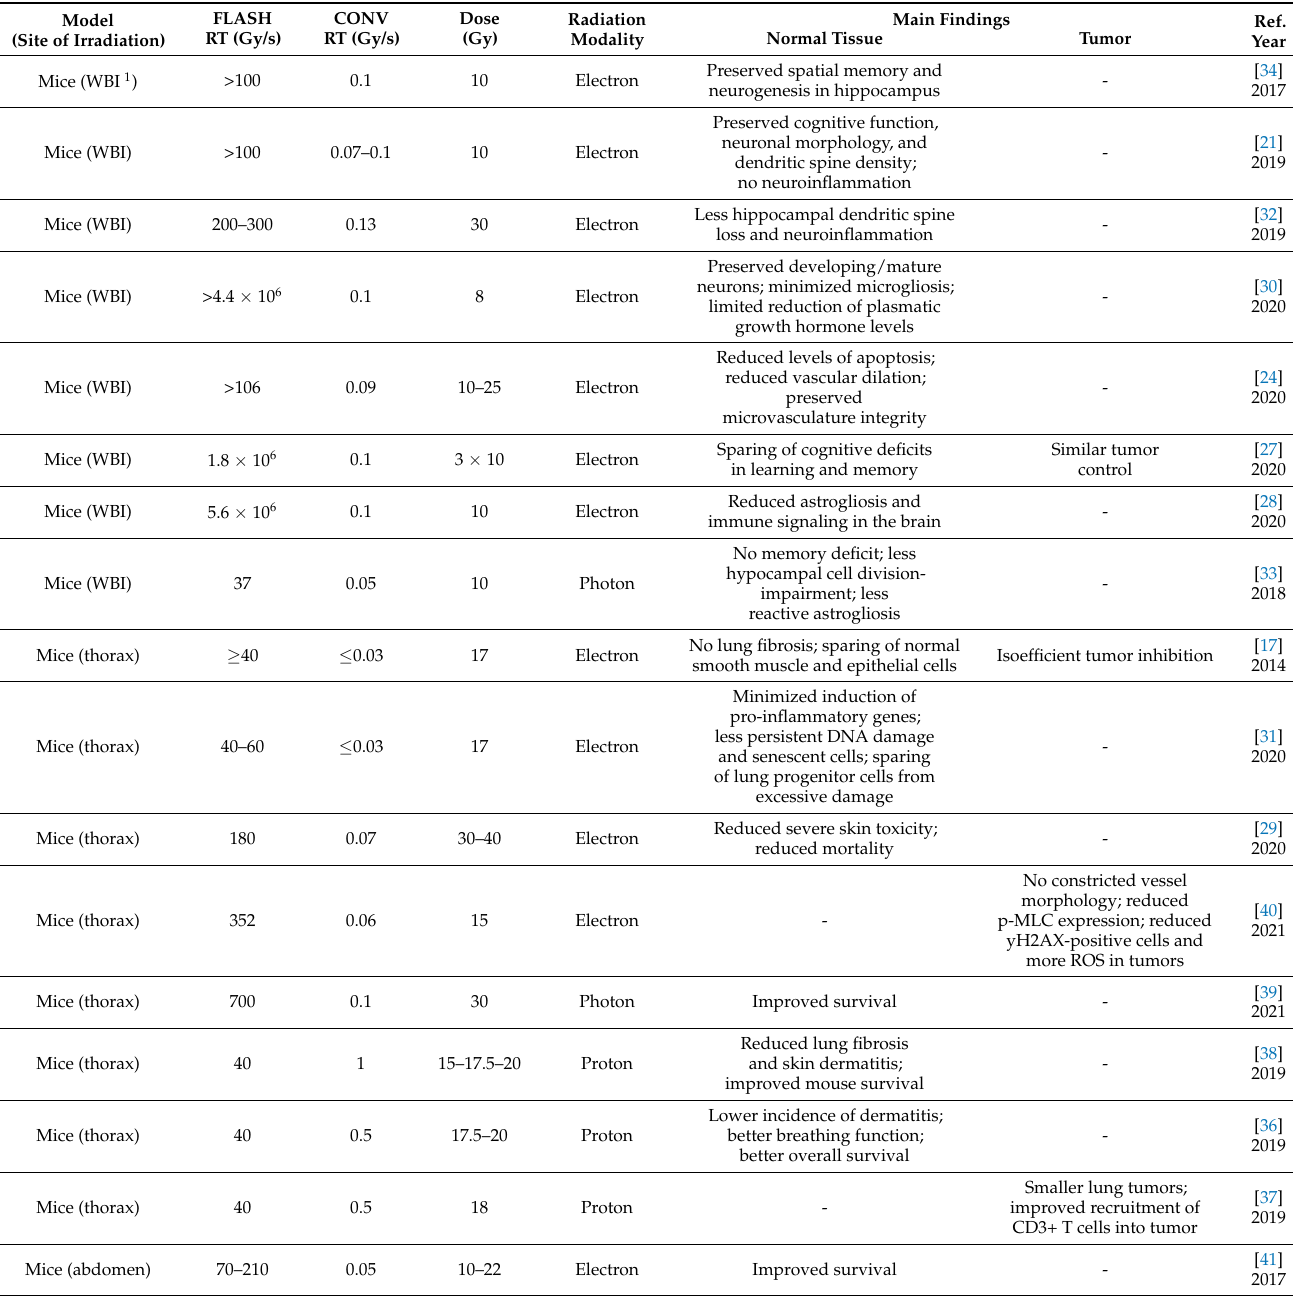
Table 1. Preclinical evidence of normal tissue sparing and equivalent tumor control after FLASH